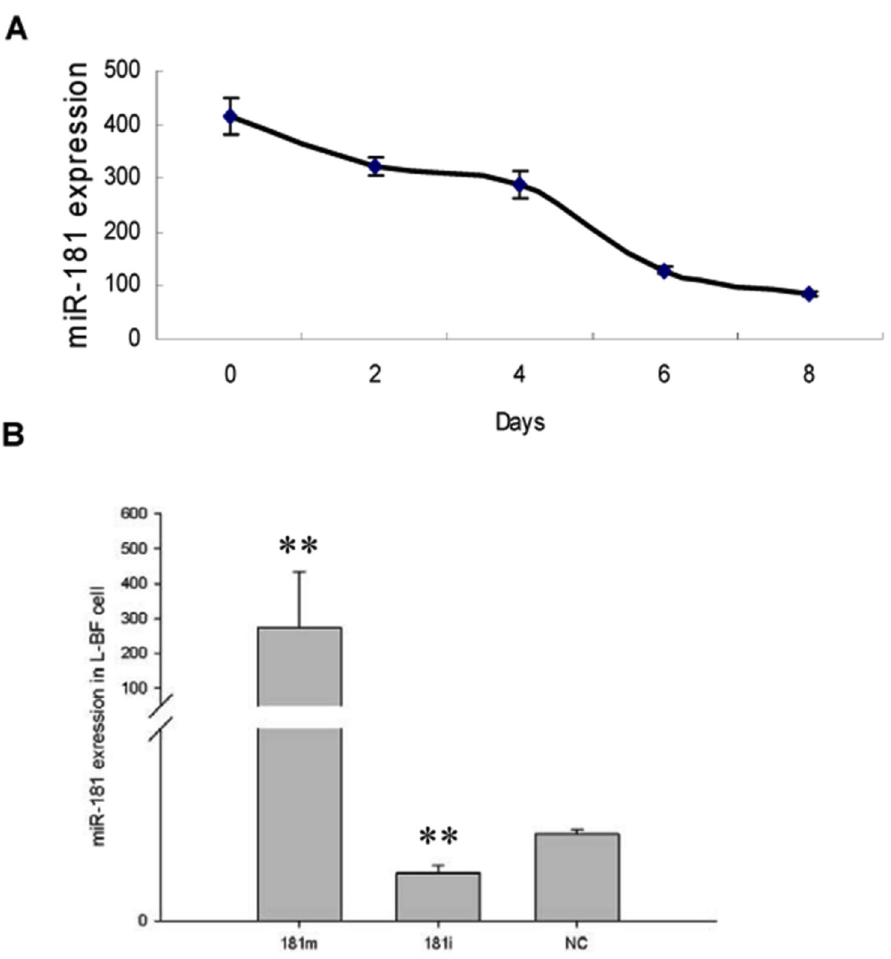
Figure 4. Level of miR-181a in porcine adipocytes after transfection of its mimic. The miR-181a mimic was transfected using Lipofectmine 2000, and endogenous miR-181a and mimics were quantified using qRT-PCR (n = 6). (A) Concentration of measured miR-181a in porcine adipocytes declined from day 0 to day 8. (B) At day 8, the measured miR-181a concentration in the miR-181a mimic transfected group remained significantly higher vs. control ( P < 0.01), while transfection of the miR-181a inhibitor resulted in a significantly lower miR-181a level vs. the control ( P < 0.01), n =